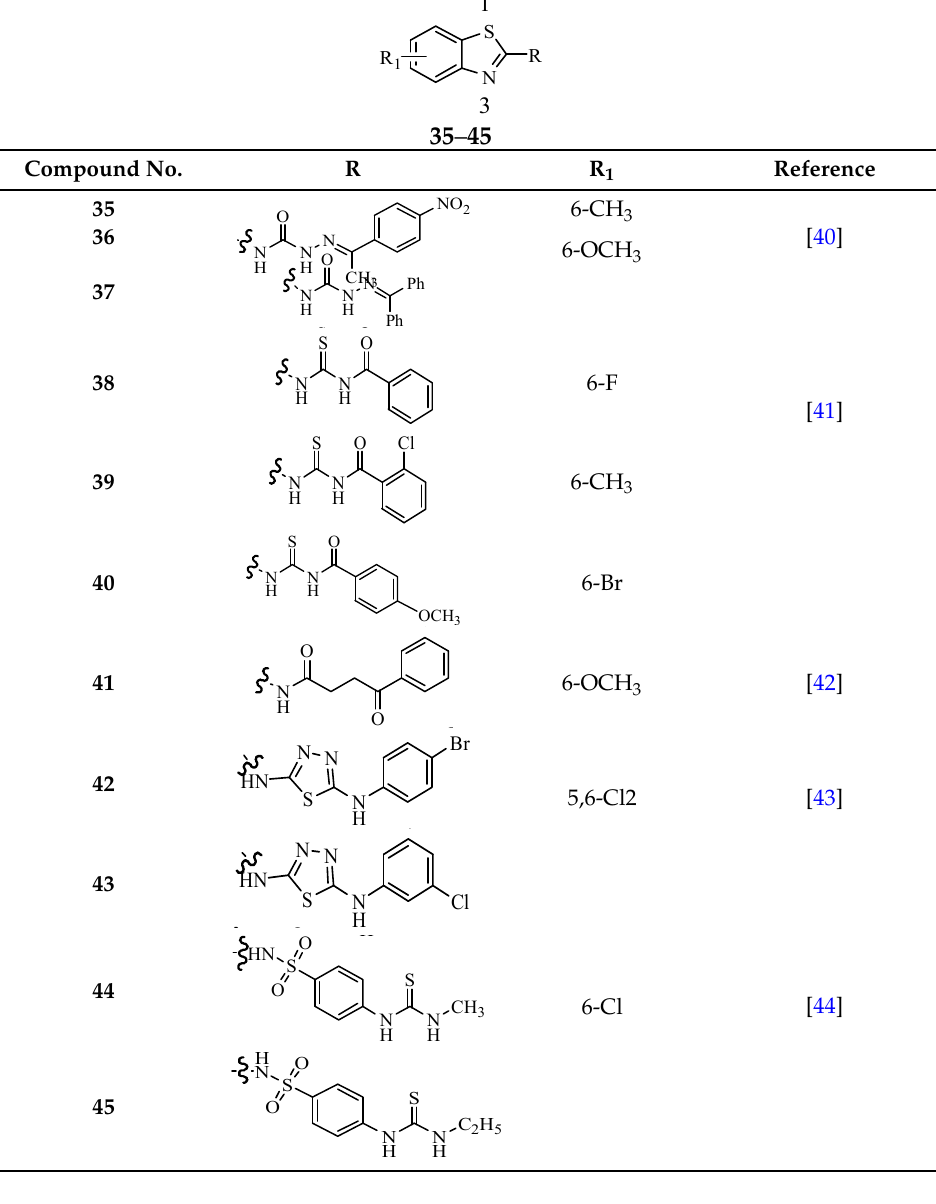
Table 3. Anticonvulsant thiazole or benzothiazole compounds.